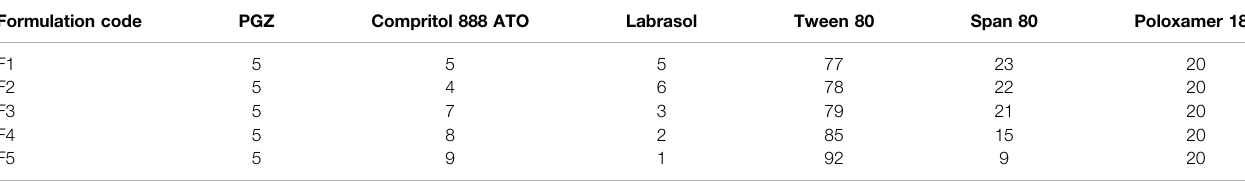
TABLE 1 | Composition of all